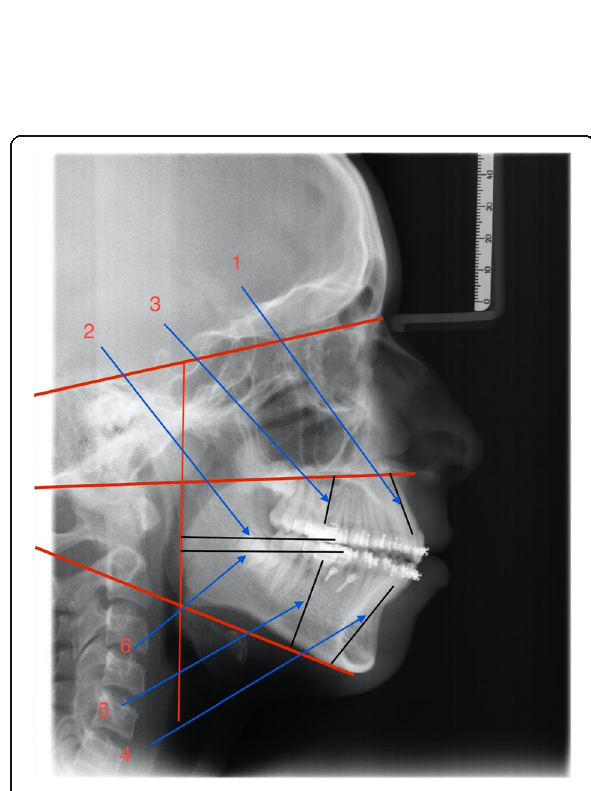
Fig. 4 Linear measurements: (1) U1 vertical position (2) U6 AP position (3) U6 vertical position (4) L1 vertical position (5) L6 vertical position (6) L6 AP